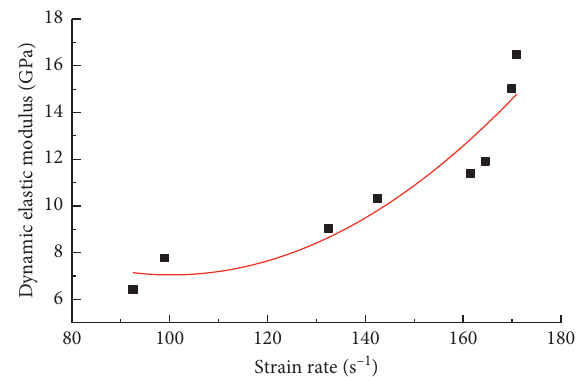
Figure 13: Changes in peak limestone intensity at different impact velocities.